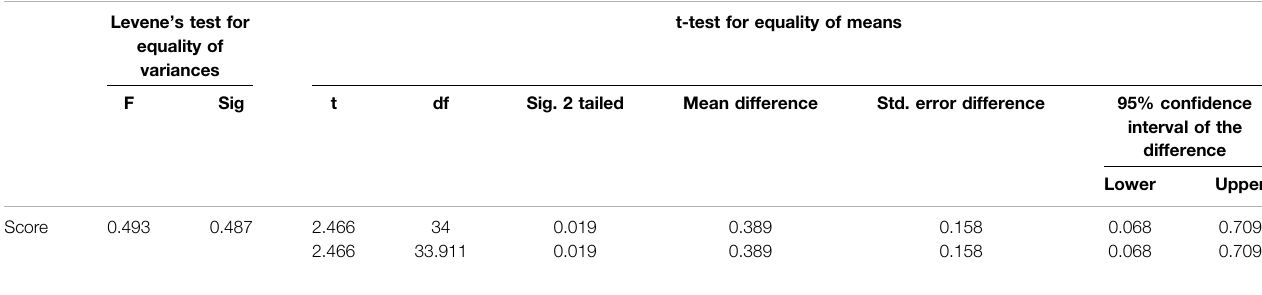
TABLE 13 | Independent Samples Test of average rankings between TEIF VI Method and Other Methods. Levene ’ s test for equality